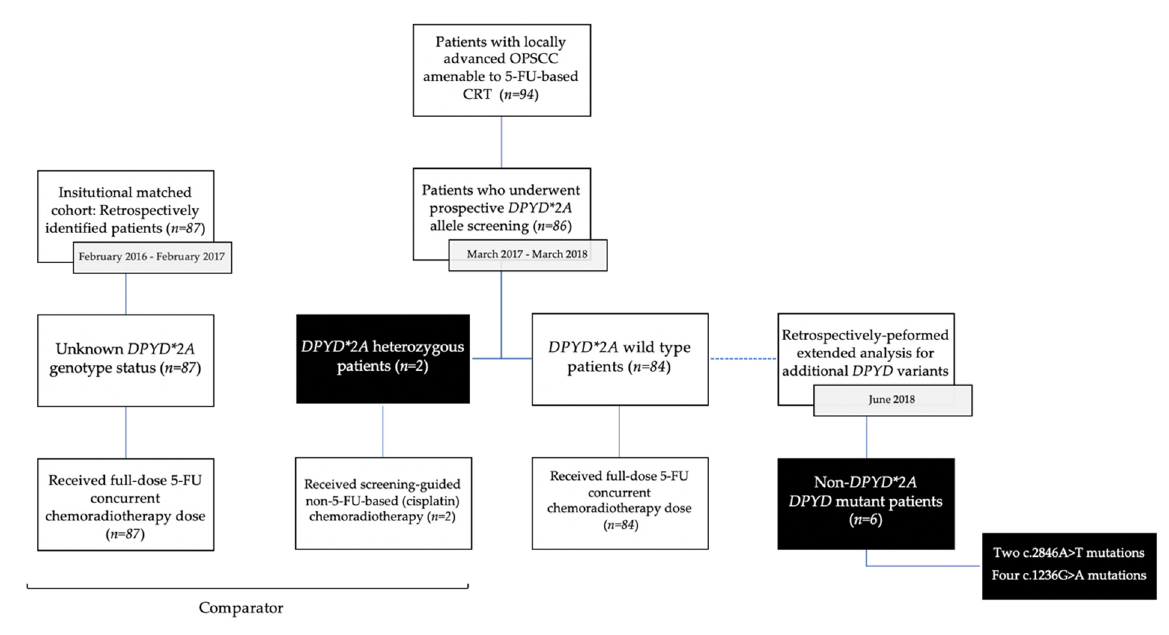
Figure 1. CONSORT Diagram. This diagram illustrates patients’ flow following initial DPYD screening and subsequent treatment according to the presence of the DPYD*2A polymorphism. Toxicities were compared between the screening cohort and a local cohort consisting of retrospectively identified patients treated with carboplatin and 5-FU-based chemoradiation. Screening for additional at-risk DPYD variants was later retrospectively performed in June 2018.